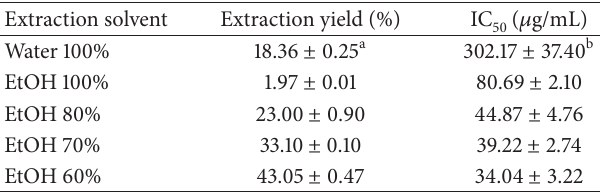
Table 1: Yield of extraction solvent composition and bioactivity of the S. baicalensis extracts by free radical-scavenging activity ABTS assay. IC 50